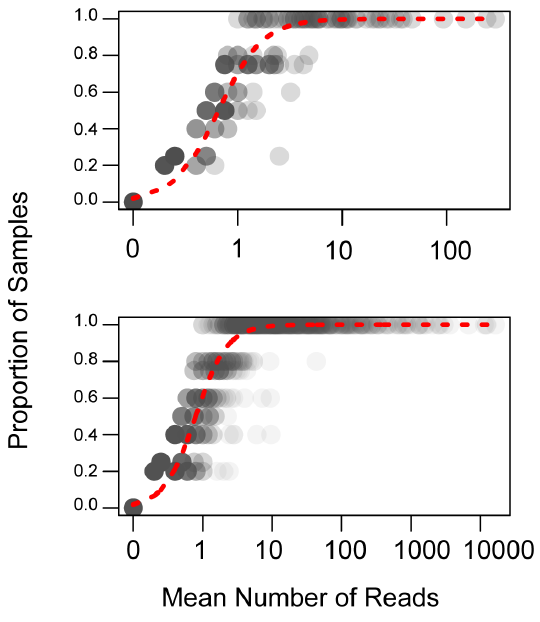
Figure 3. Taxa represented by more sequences are observed most consistently across replicates of the same sample. Plots of the proportion of samples in which an OTU is observed against the average number of reads representing that OTU. Zeros were assigned a value of 0.1 prior to log transformation. Dashed lines represent the logistic model predicting the relationship. The top panel shows results from 454 and the bottom panel shows results from Illumina.